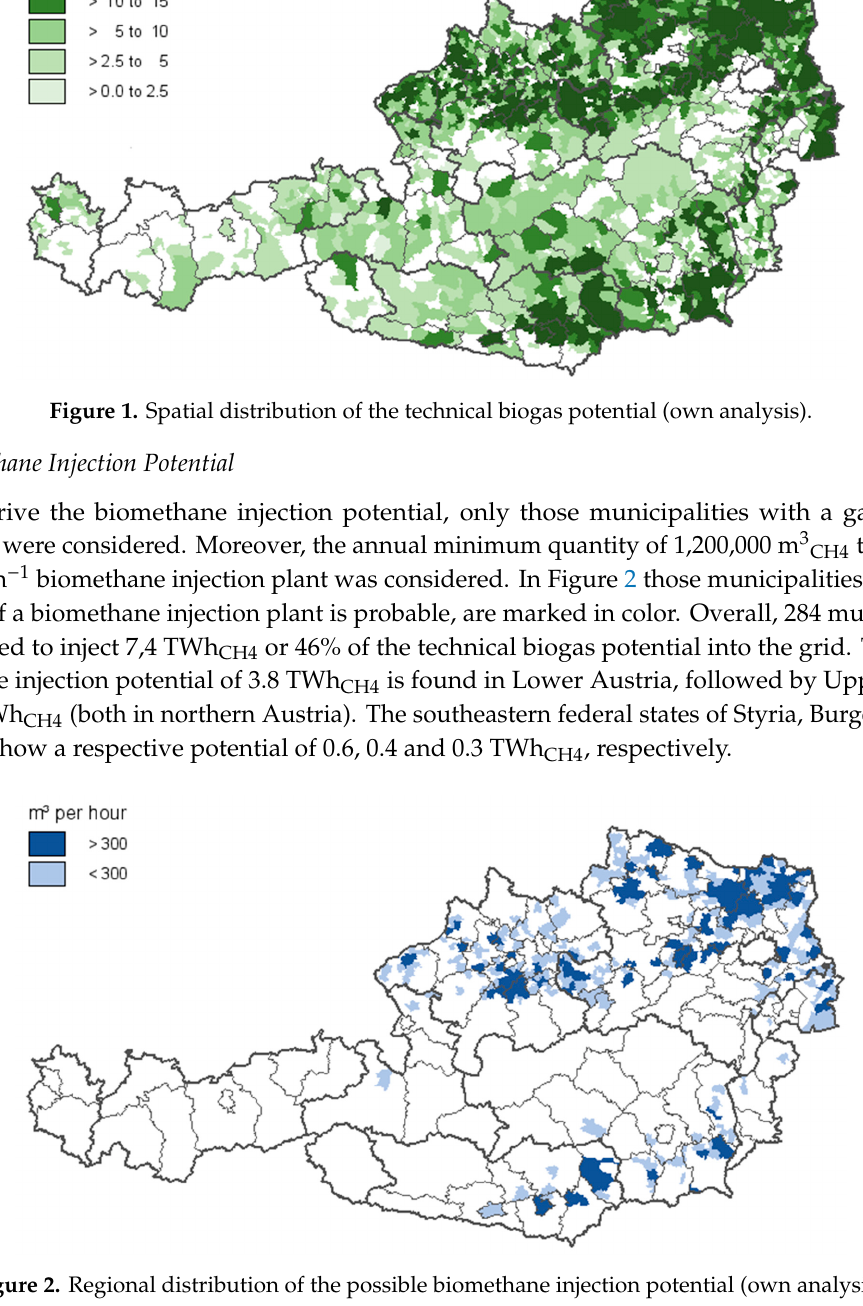
Table 3. Theoretical and technical potential compared to current potential studies in Austria.